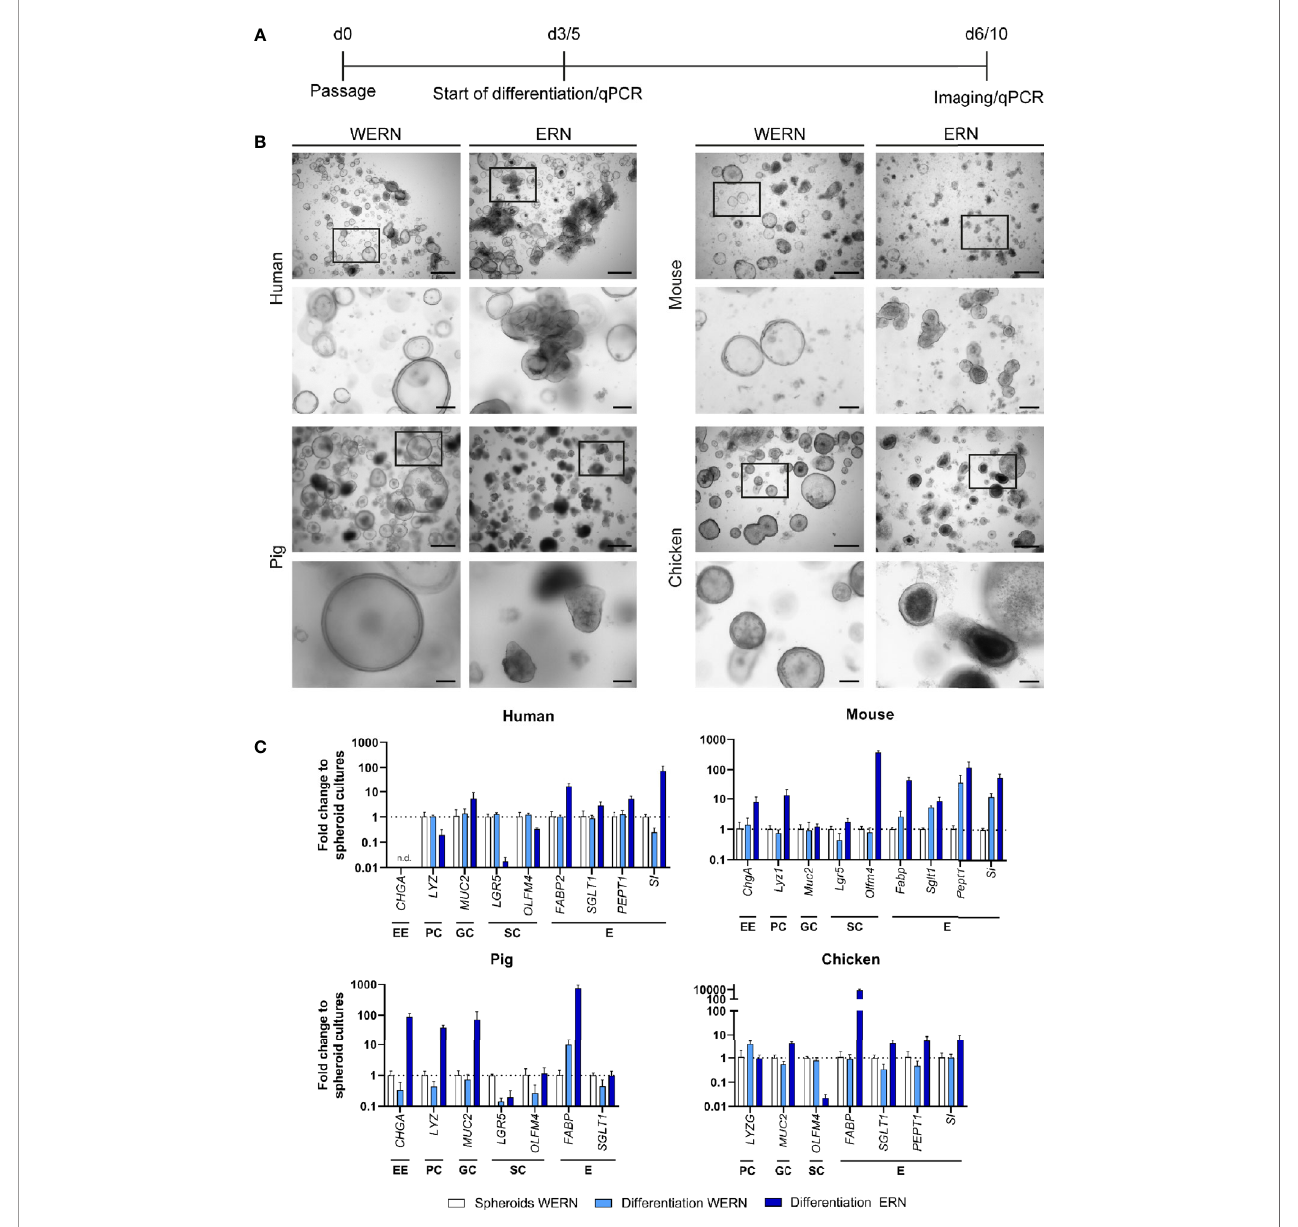
FIGURE 1 | Characterization and differentiation of 3D spheroids/organoids from human, mouse, pig and chicken origin. (A) A new spheroid culture was cultured for 3 days (5 days for human) in WERN medium and then spheroids were either maintained in WERN medium or differentiated in ERN medium for further 3 days (human for 5 days). At indicated time points, spheroids/organoids were imaged and/or harvested for RNA extraction and transcriptional analysis by RT-qPCR. (B) Representative bright fi eld microscopic images of spheroids/organoids. Scale bars represent 500 µm (upper panel in each species) and 100 µm (lower panel in each species). (C) Quanti fi cation of marker genes speci fi c for various intestinal cell types by RT-qPCR. Note that the data are normalized to the transcript abundance of 3/ 5 day WERN spheroid culture. EE, enteroendocrine cell; PC, Paneth cell; GC, goblet cell; SC, stem cell; E, enterocyte. RT-qPCR experiments show mean (± 95% CI) of ≥ 4 technical replicas of at least two independent biological replicates. n.d., not